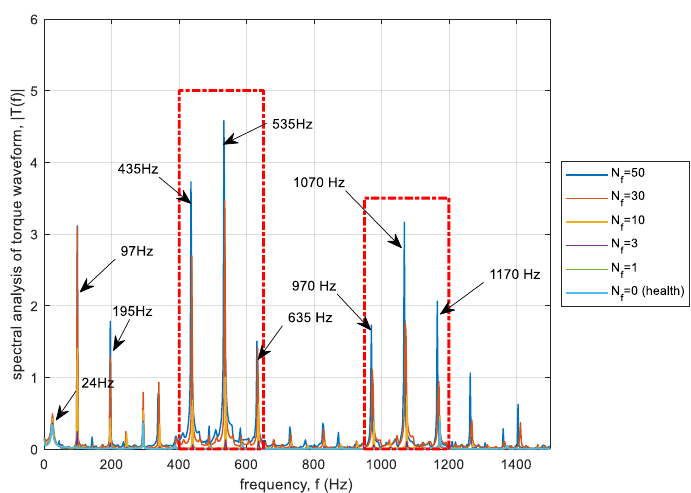
Figure 11. Spectral analysis of the torque waveform of a faulty motor, at T L = 0 Nm.